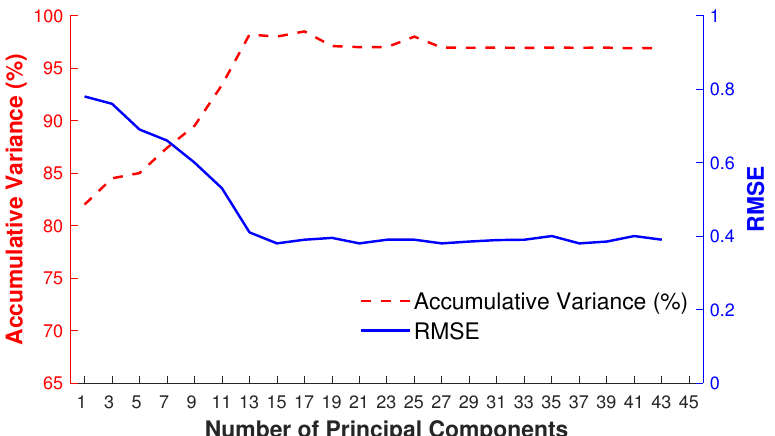
Figure 9. Accumulative variance (%) and RMSE for the dynamic selection of the number of princi- pal components.